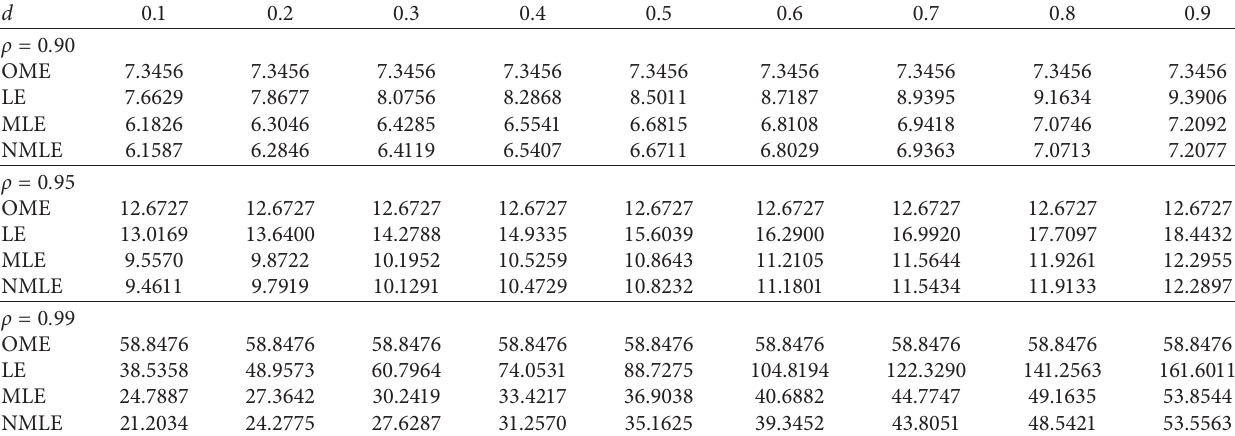
Table 4: MSE values of the estimator for different values of d and ρ when σ � 5 and n � 50.